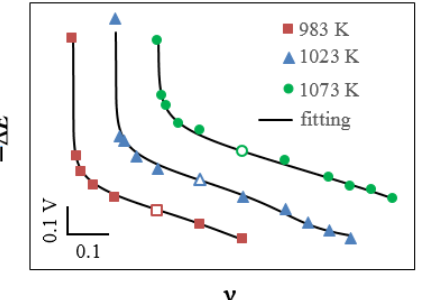
Table 1. Equilibrium constants of Reactions (23)–(26).